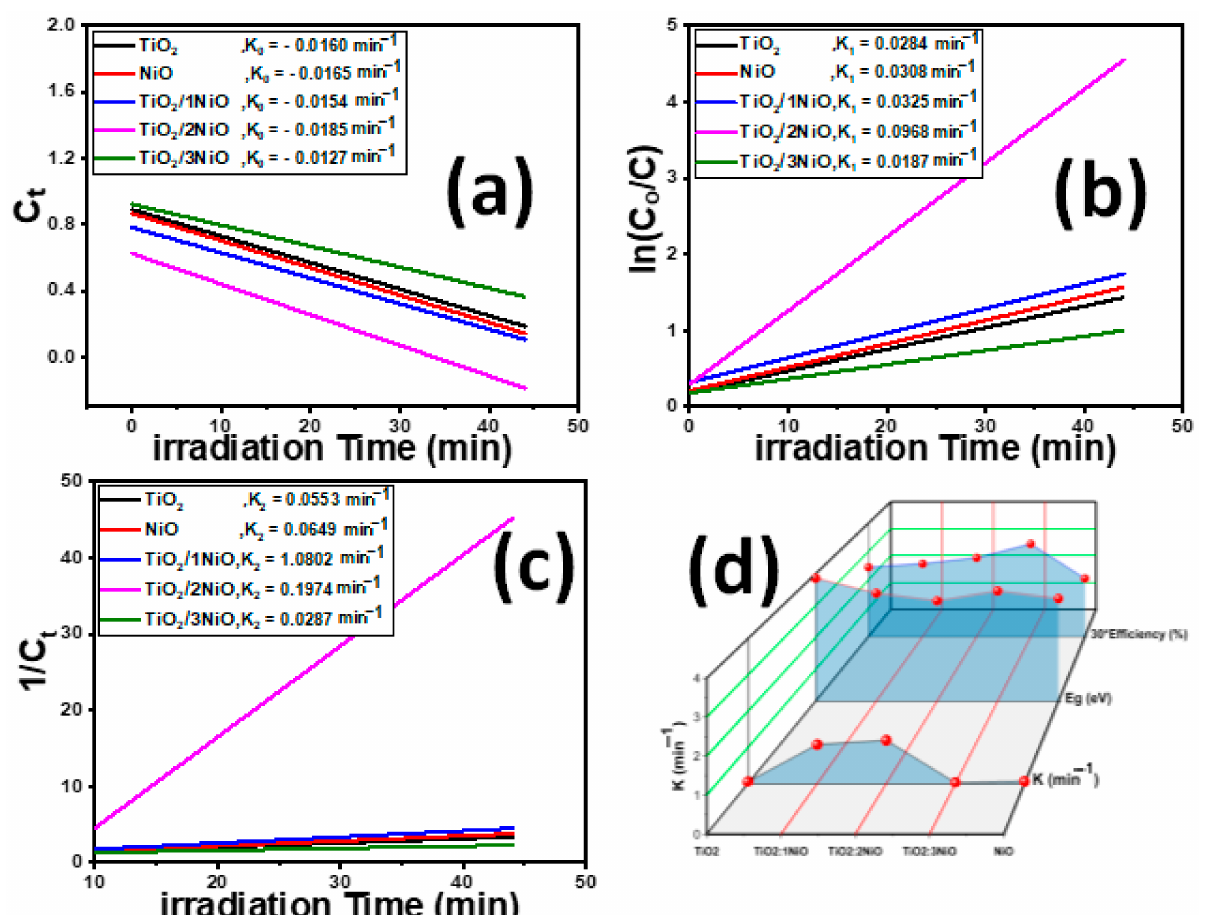
Figure 7. Kinetic study of the catalytic photodegradation of MB solutions using the prepared nanopowders under sunlight ( a ) zero-order, ( b ) first-order, and ( c ) second-order kinetic models, and ( d ) kinetic constants vs. Eg and Efficiency. Table 2. The kinetic parameters of the studied models for MB photodegradation using different photocatalysts.